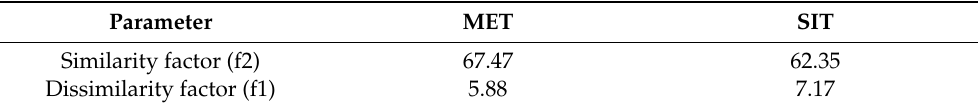
Table 6. Release profile comparison after stability conditions of the optimized formulation (R4).